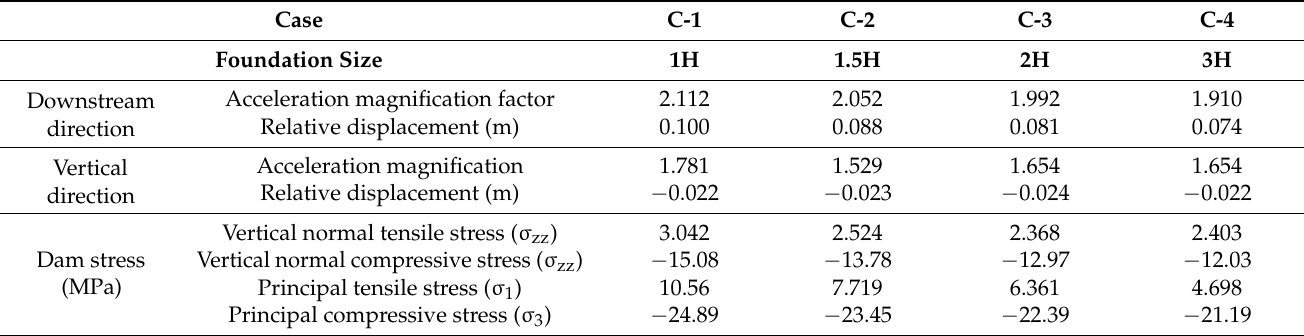
Table 7. The extreme values of dam dynamic responses for different foundation sizes (VABF).